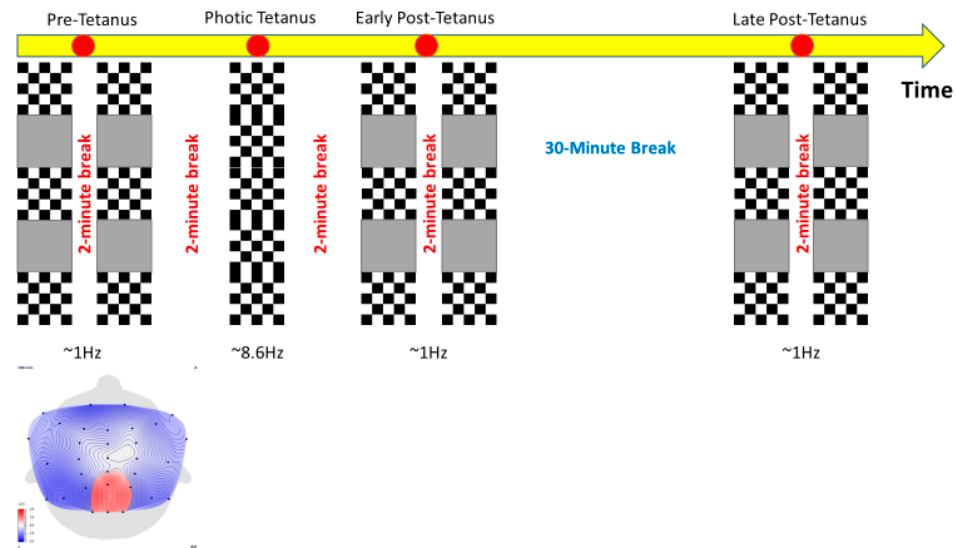
Figure 2. Visual stimulus paradigm. The pre-tetanus, early post-tetanus, and late post-tetanus blocks are comprised of interspersed presentations of 420 horizontal black and white reversal checkerboards presented for seventy seconds separated by fifteen seconds of a black screen with no checkerboards. During the pre-tetanus, early post-tetanus, and late post-tetanus blocks, the checkerboards were presented centrally at a rate of 1 Hz. The photic tetanus consisted of 1000 consecutive presentations of horizontal black and white reversal checkerboards presented centrally lasting for ~2-min. The pre-tetanus, early post-tetanus, late post-tetanus and photic tetanus blocks are separated by two-minute breaks (eyes closed) to allow for any retinal after-image to dissipate. A 30-min rest period occurred between the early post-tetanus and late post-tetanus.